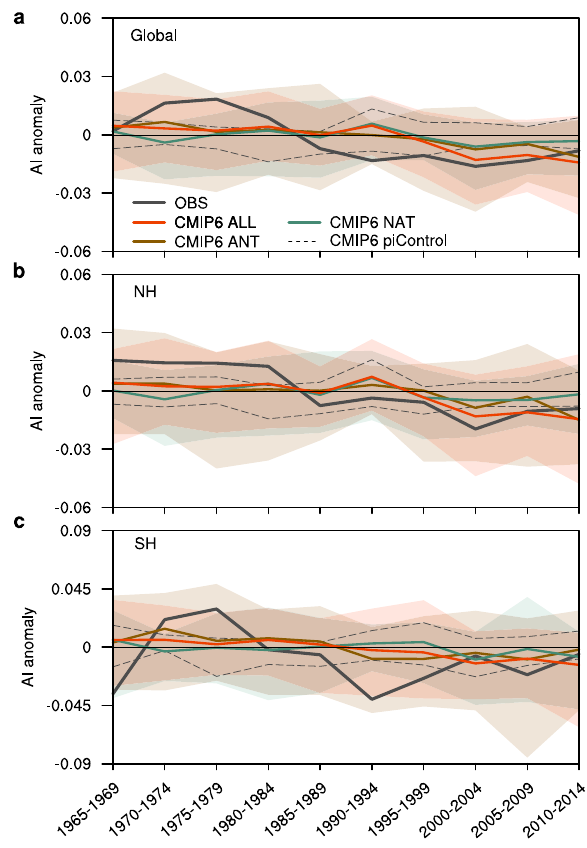
Fig. 2 Observed and simulated 1965 to 2014 time series of AI anomalies (relative to 1973 to 2002). The 5-yr mean annual AI anomalies overland of the globe ( a ), NH ( b ), and SH ( c ) for the mean of observations (OBS) and CMIP6 simulations accounting for ALL, NAT, and ANT forcings. The ensemble means for each set of forcings are given in red, green, and brown solid lines for ALL, NAT, and ANT, respectively. The observation means are indicated with solid black lines. Red, green, and brown shading represent the 5 – 95% ranges for ALL, NAT, and ANTensembles, respectively. The gray dashed lines represent the 5% – 95% ranges for the range of variability for the